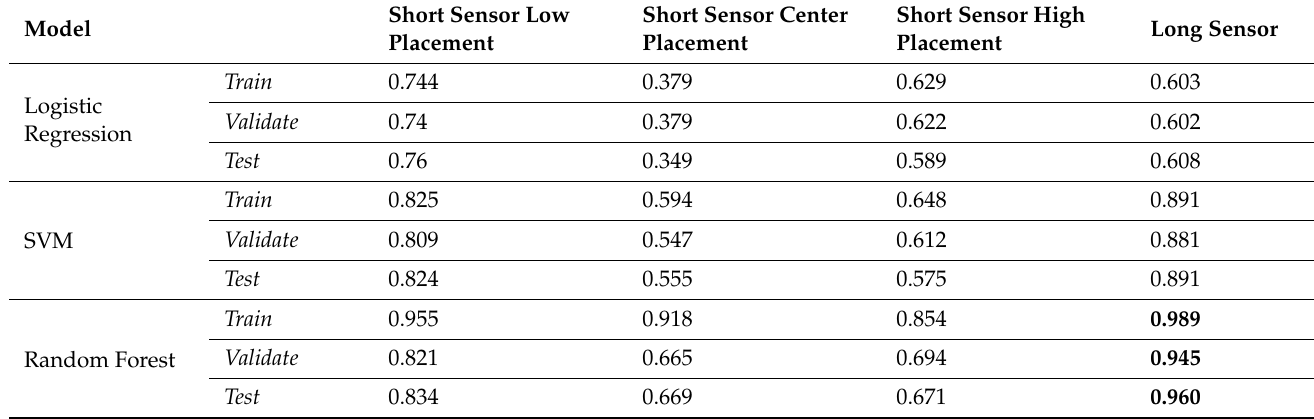
Table 1. Fivefold training, cross-validation, and held-out test accuracy of classical ML models with different feature sets. The bold font denotes the cases with the highest accuracy for that model. These results are for the three-class